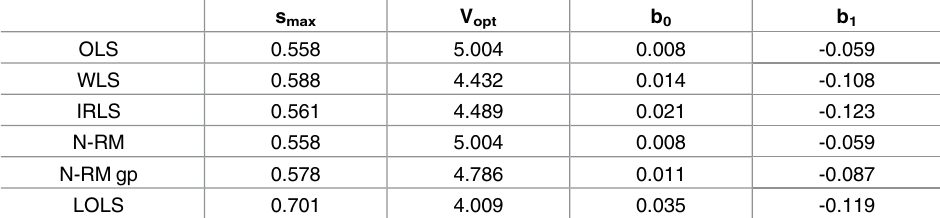
Table 2. The overall survival function with parameters estimated by different methods. Samplesize n =